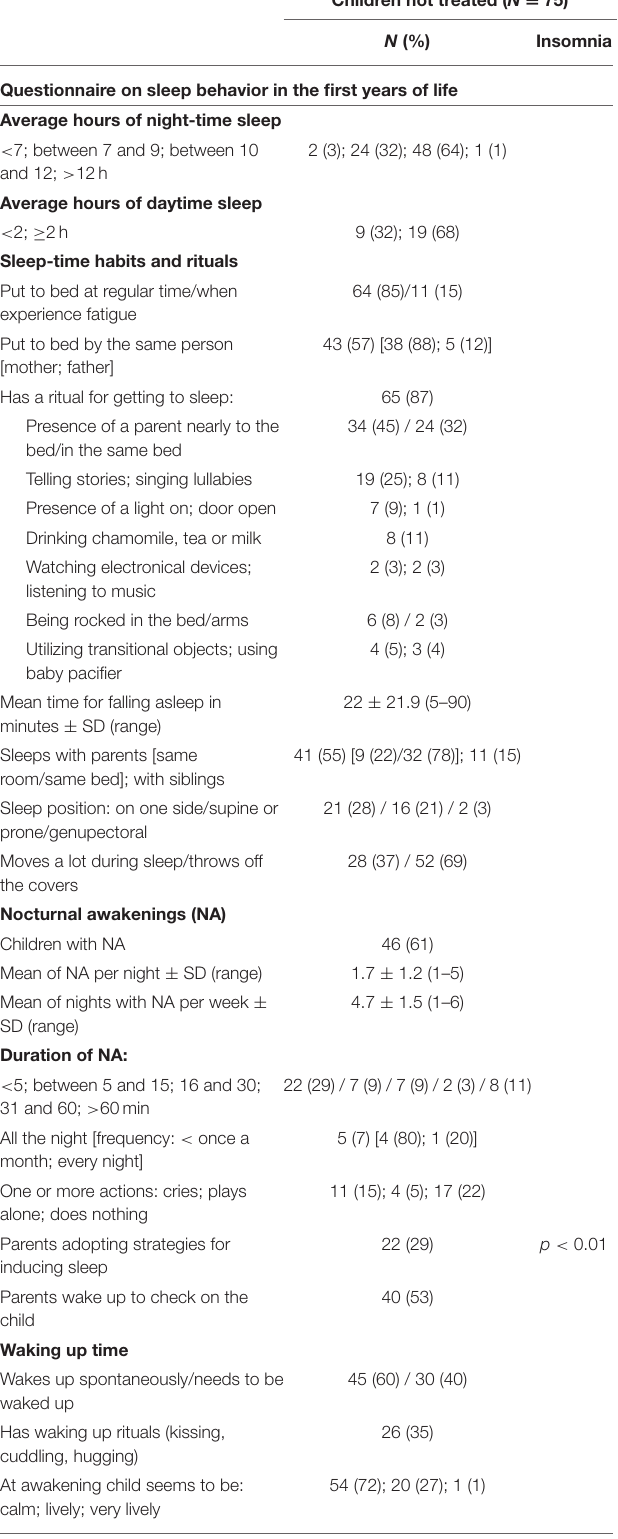
TABLE 4 | Sleep characteristics according to the two sleep questionnaires. Children not treated ( N =